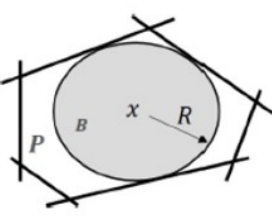
Figure 4. Largest compact set B circumscribed in a convex set of P